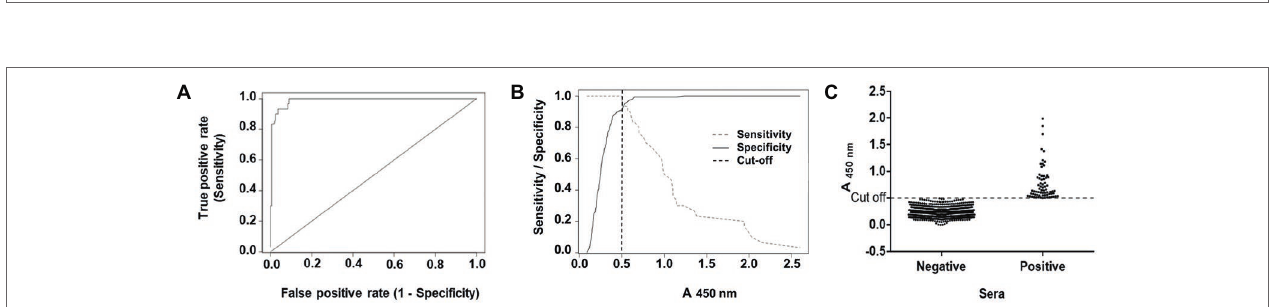
FIGURE 2 | ROC curve, sensitivity and specificity graph of the in-house ELISA, and seroprevalence of anti-HEV IgG antibodies in blood donors. (A) ROC curve obtained with 197 characterized sera for their reactivity to HEV. (B) The cut-off value of the assay (A 450nm values = 0.498) as determined by the optimal values of the sensitivity (dashed gray line) and specificity (full black line) curves. (C) Prevalence of anti-HEV antibodies in 813 blood donors. Results are depicted as absorbance values at λ = 450 nm. Samples with A 450nm values > 0.498 were considered as positive using the optimal parameters determined before for the ELISA.